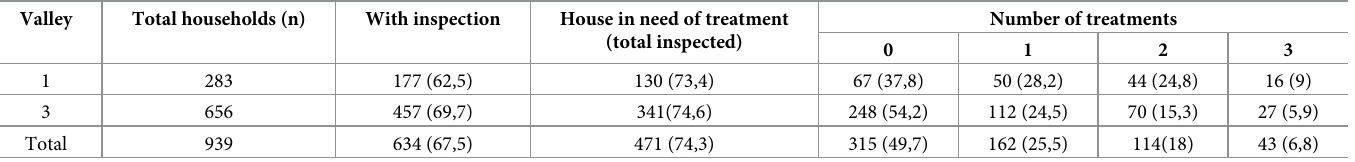
Table 1. The proportion of inspections households per intervention site (valley 1 and 3).